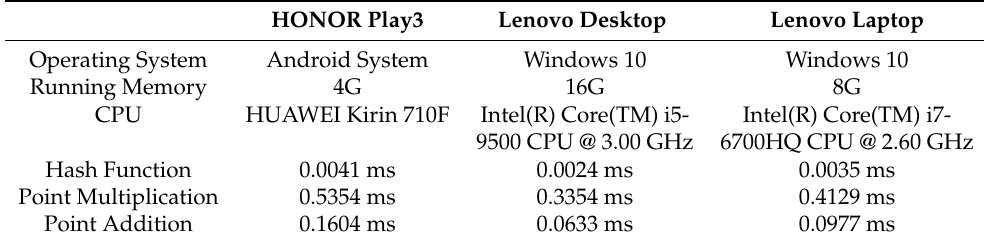
Table 4. Configuration parameters and running time of equipment.